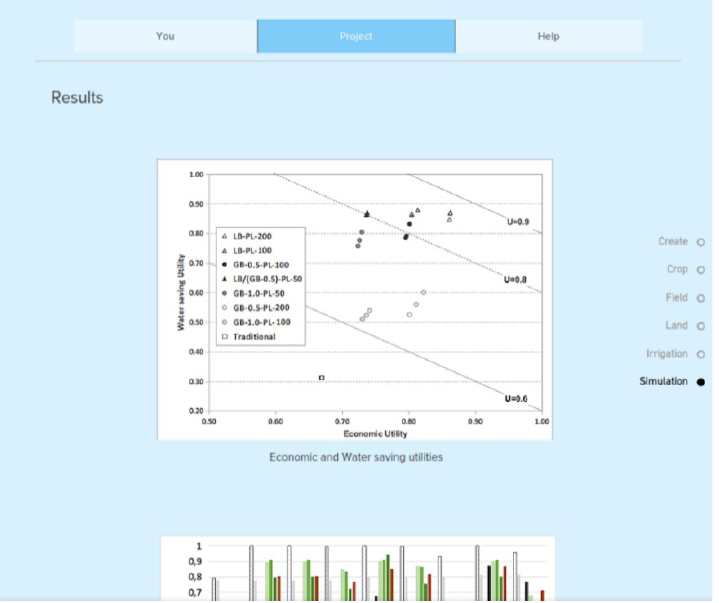
Figure 6. Example of a graphical output of irrigation alternatives